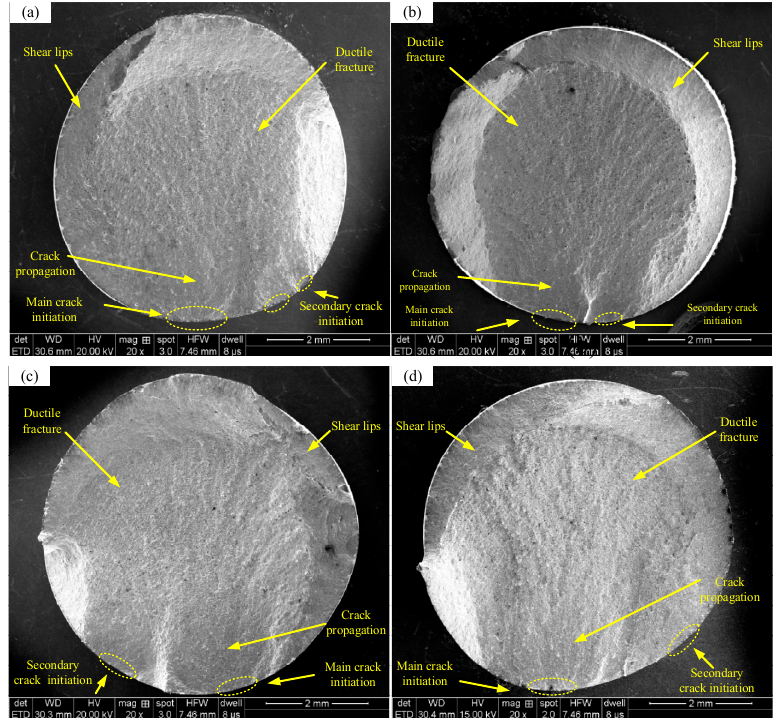
Figure 9. Fracture morphology of the specimen under different surface conditions: ( a ) SI, ( b ) SII, ( c ) SIII, and ( d ) SIV.